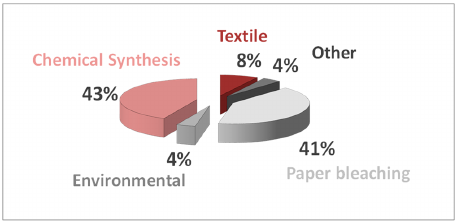
Figure 1. Main applications of H 2 O 2 . 44